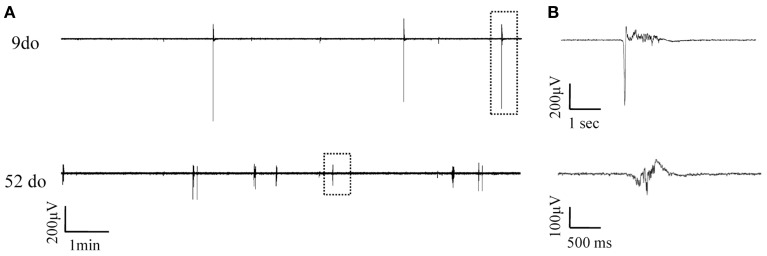
Simultaneously recorded spontaneous Up states in slices from mice of two distinct ages. (A) Continuous field potentials recorded from S1BF cortical slices of a 9do (top panel) and a 52do (middle panel) placed side-by-side in the recording chamber. (B) Higher magnification of individual Up states as designated by the dotted box in (A).